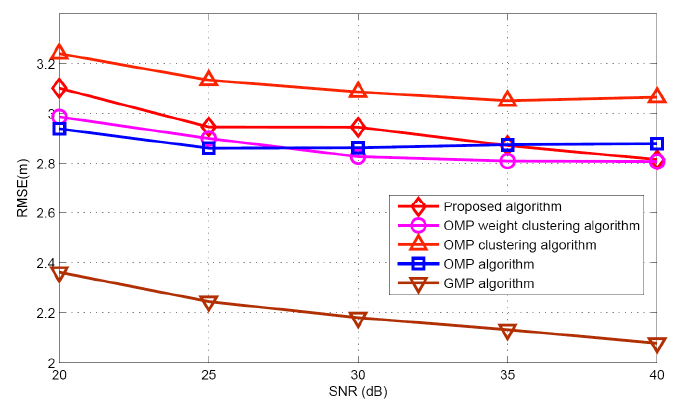
Figure 13. False alarm rate versus SNR.